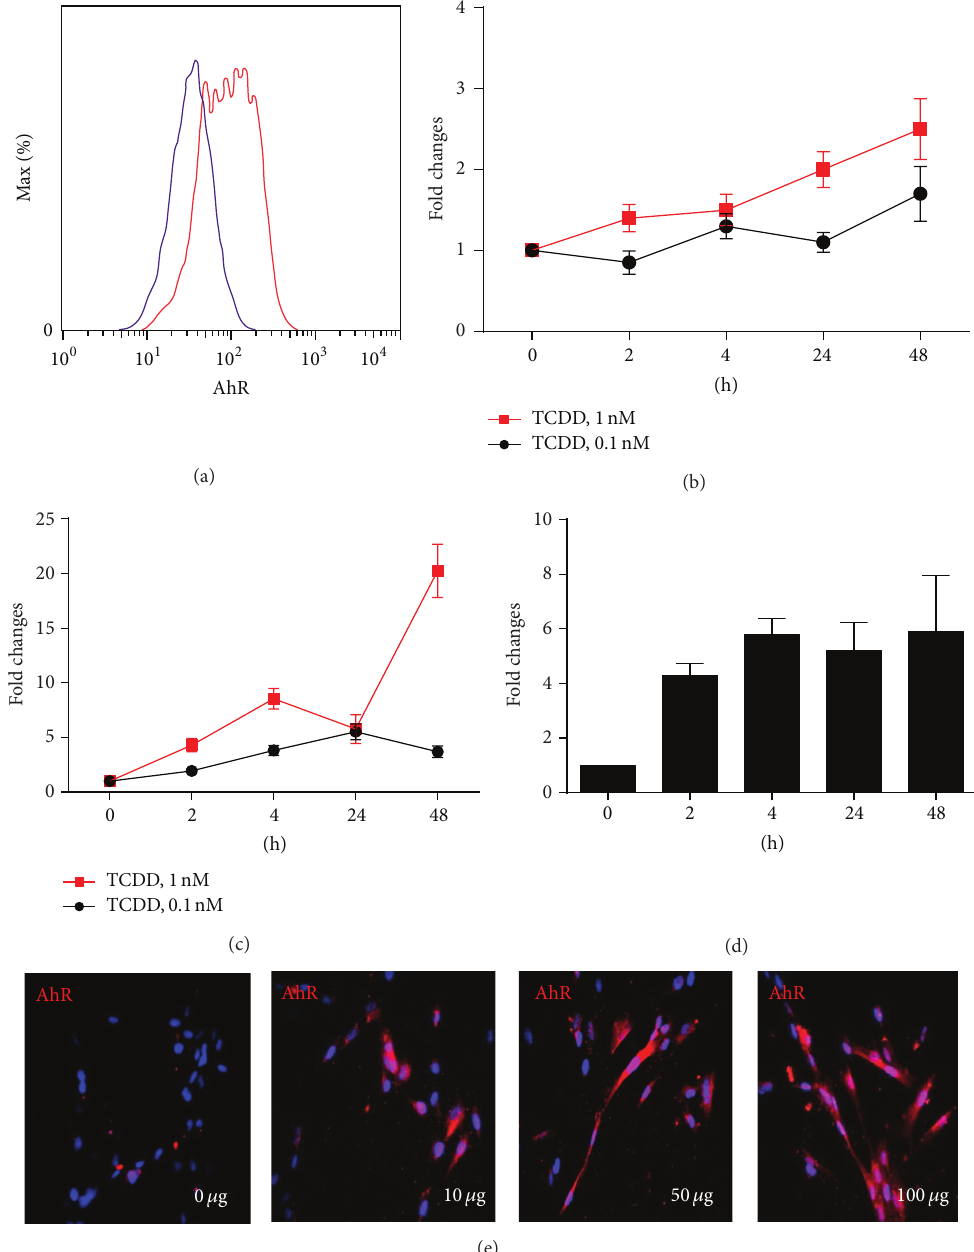
Figure 2: AhR expression in CRE-treated human lung fibroblasts. (a) AhR expression in WI-38 was detected using antibody against AhR (red line) and IgG2 (blue line) by flow cytometry. (b-c) Fibroblasts were treated with different doses of TCDD (0.1nM and 1nM) for 2 to 48 hours; expressions of cyp1a1 (b) and cyp1b1 (c) were examined by RT-PCR. (d) Fibroblasts were treated with 50 𝜇 g/mL CRE for 2–48 hours and AhR expression was examined by RT-PCR. (e) Immunofluorescence analysis of AhR expression in CRE-treated fibroblasts at various doses (0–100 𝜇 g/mL). Bars represent mean ± SEM of 3 independent